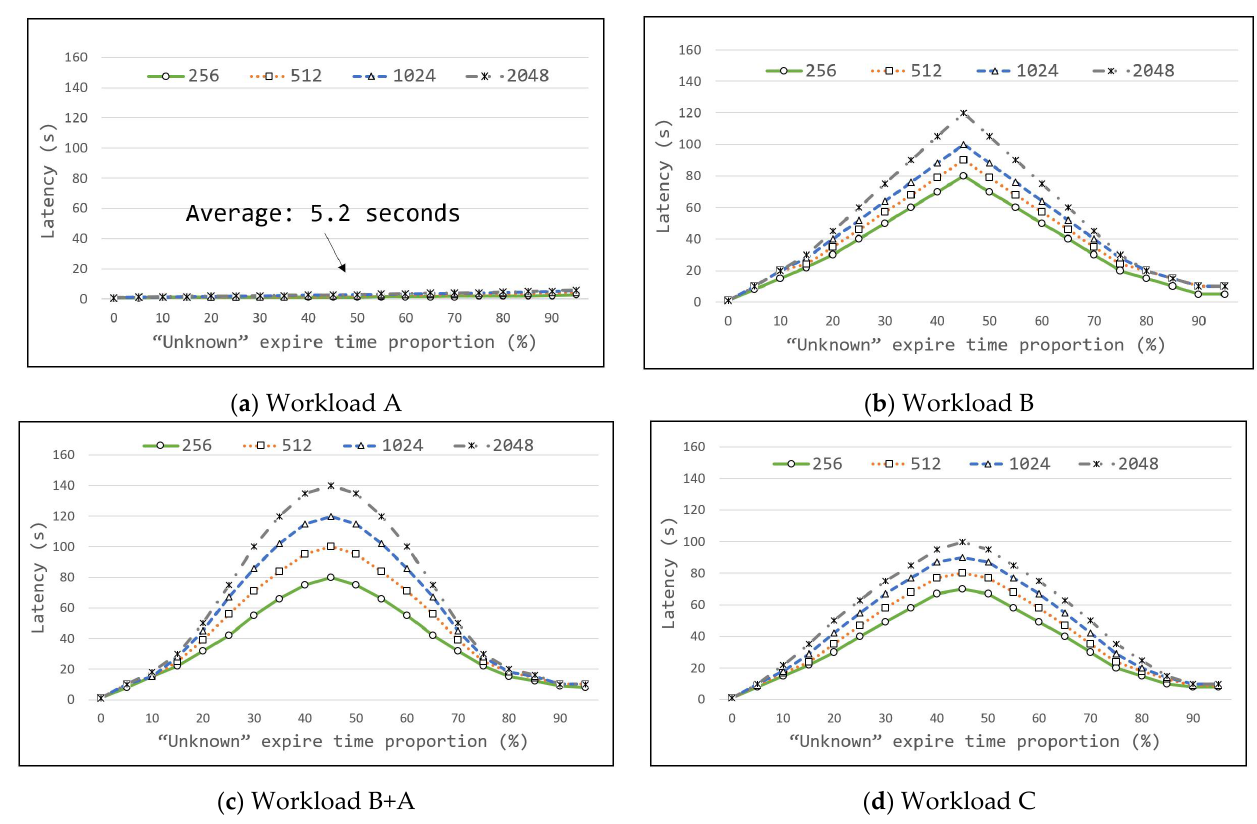
Figure 5. Evaluation results.